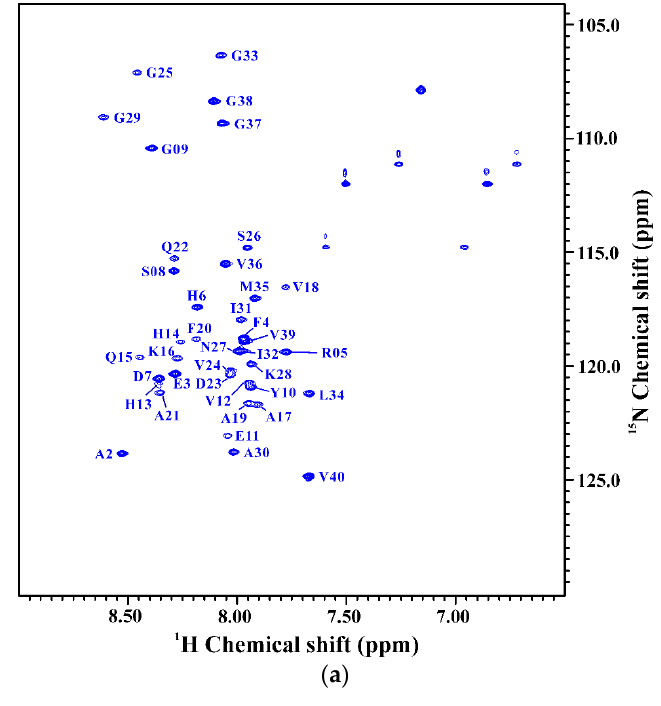
Figure 4. The predicted secondary structures of the α / β -discordant regions of wild-type A β 40 A β 40 (E22Q) and A β 40 (L17A/F19A/E22Q). β -strands predicted with high and low probability were denoted by the symbols E and e, respectively. α -helical structures predicted with high and low probability were denoted by the symbols H and h, respectively